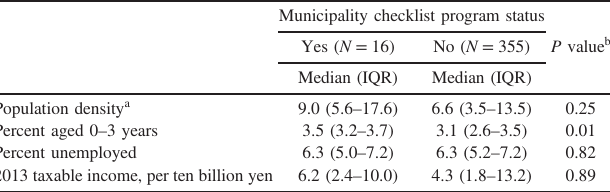
Table 2. Municipal characteristics by implementation status of a infant safety checklist